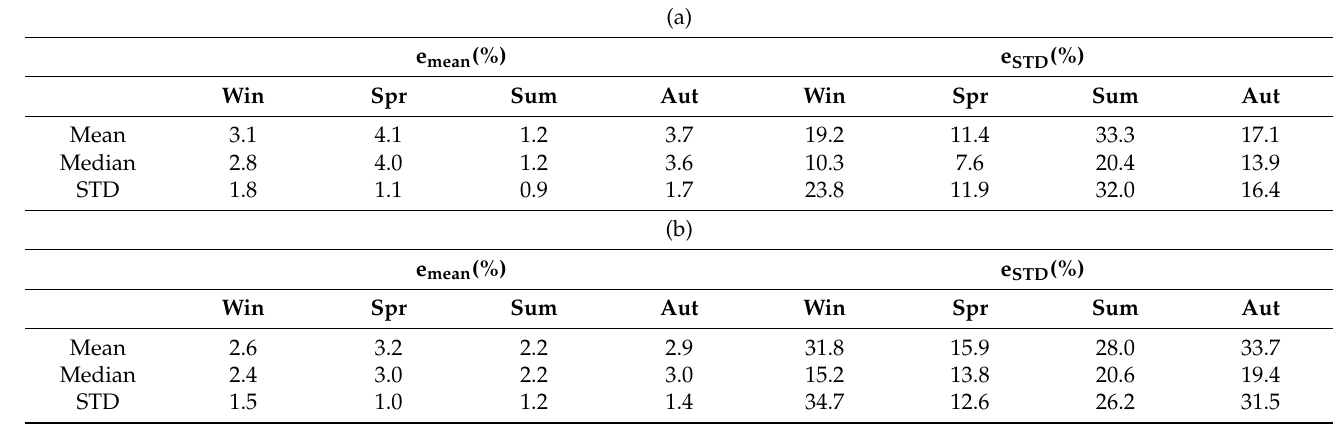
Table 5. (a) Mean, median, and standard deviation (STD) of the errors on the mean (e mean ) and the standard deviation (e STD ) evaluated in the case of synthetic soil moisture daily profiles, for the Patern ò case study, using data of individual seasons of individual years. (b) Mean, median, and standard deviation (STD) of the errors on the mean (e mean ) and standard deviation (e STD ) evaluated in the case of synthetic soil moisture daily profiles, for the Busachi case study, using data of individual seasons of individual